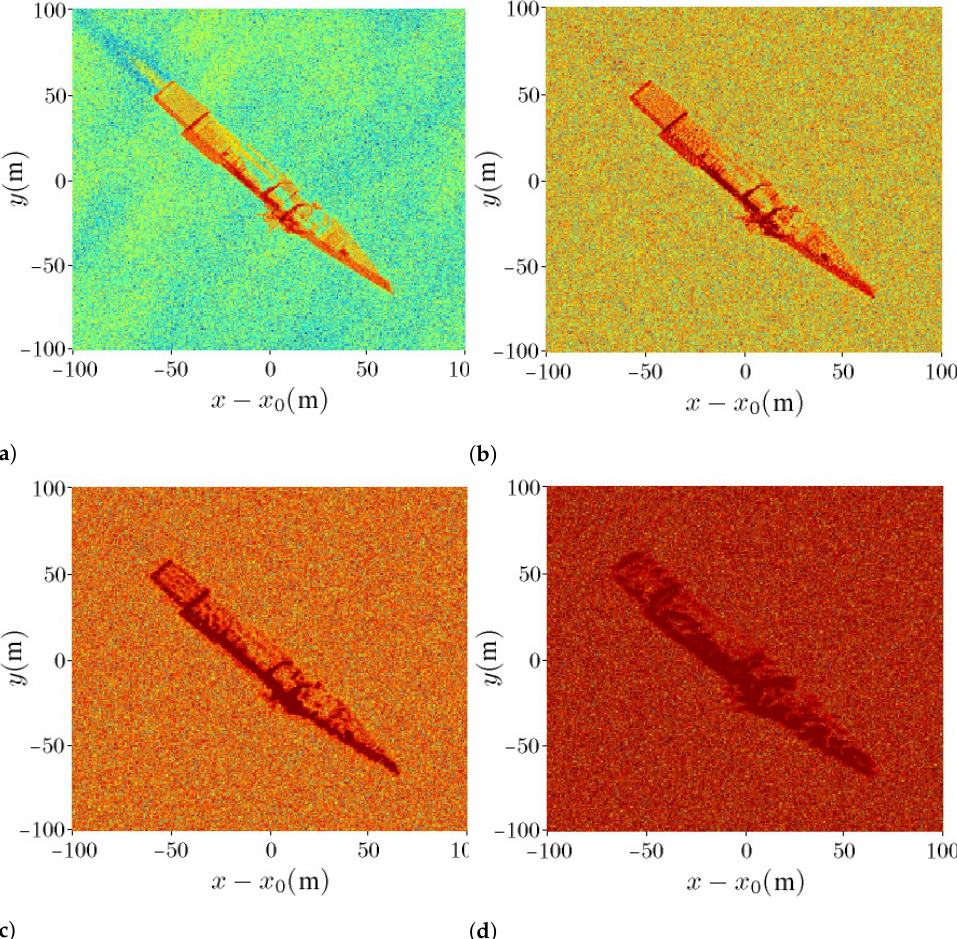
Figure 20. Acquired image of Arleigh Burke-class destroyer in scale of (40, 90) dB, with SNR equal to ( a ) 0 dB, ( b ) − 5 dB, ( c ) − 10 dB, and ( d ) − 15